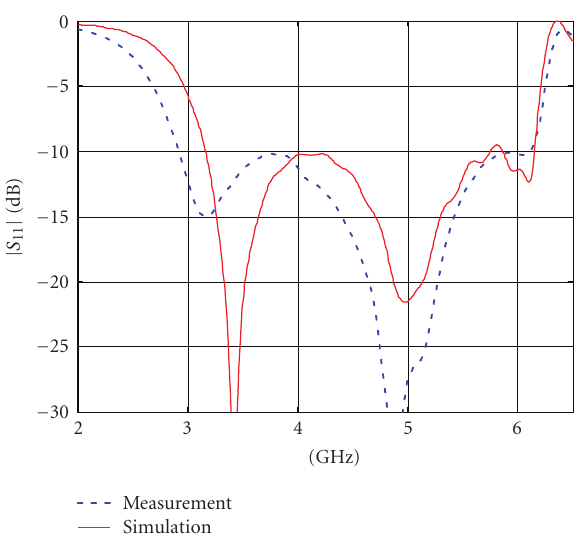
Figure 2: Measured and simulated reflection coe ffi cient magnitude | S | versus 11